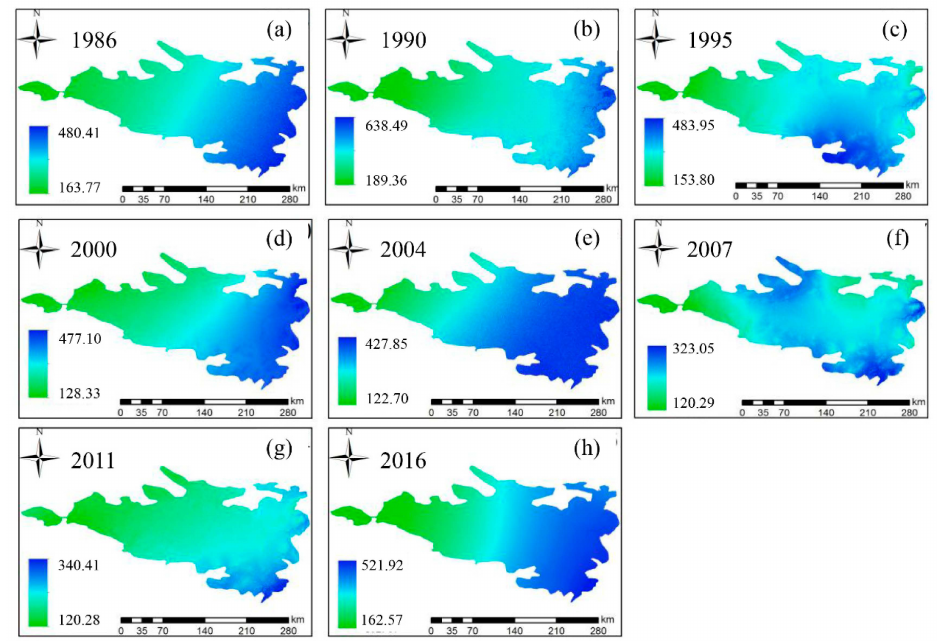
Remote Sens. 2023 , 15 , 279 Figure A1. Spatial-temporal distribution of annual precipitation from 1986 to 2016.